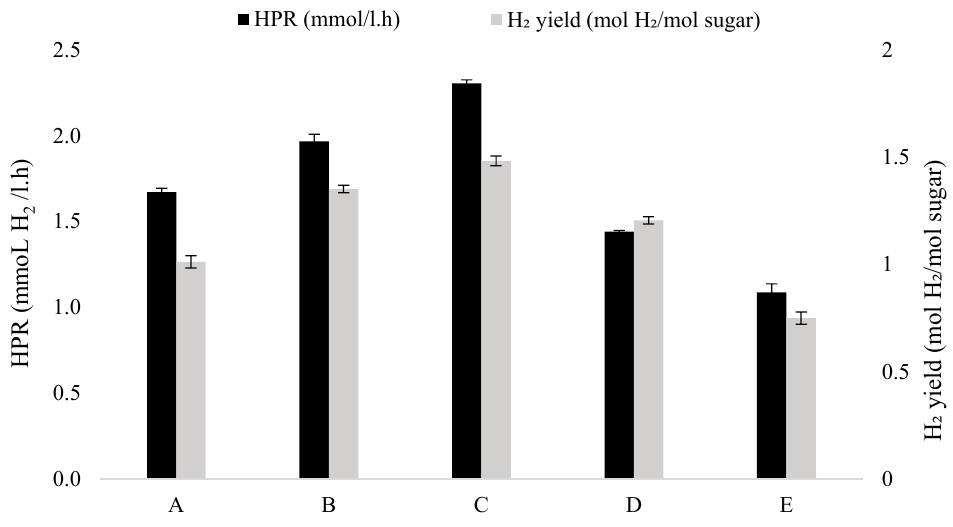
Figure 4. Hydrogen productivity rate (mmol H 2 /l.h) and hydrogen yield (mol H 2 /mol sugar) in the different concentrations of alginate for hydrogen production.